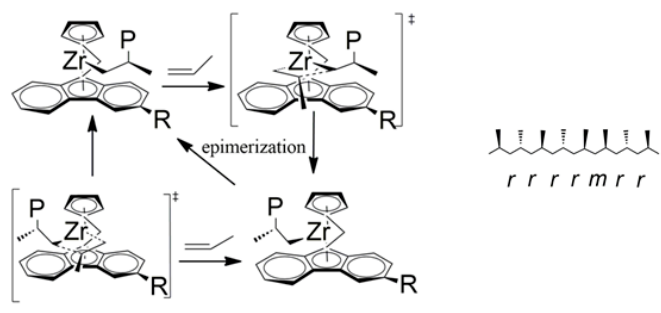
Figure 8. Enantiomorphic site control polymerization mechanism with catalysts 1 and 2 : chain migratory mechanism with accessible backskips of the polymer chain to its original position.